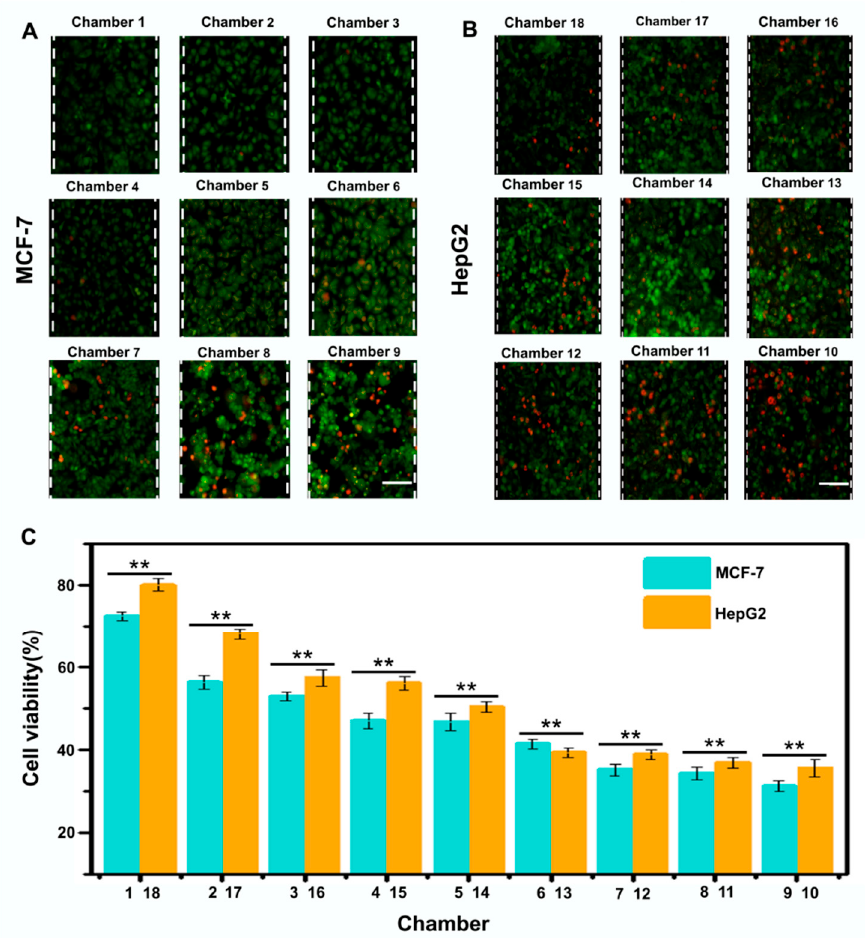
Figure 6. Responses of two tumor cells (human breast adenocarcinoma cells (MCF-7) and human cervical carcinoma cells (HepG2)) to different drug-concentration gradients (paclitaxel). ( A , B ) Acridine orange/propidium iodide (AO/PI)-stained fluorescence images of MCF-7 cells (A) and HepG2 cells ( B ) in different microchambers after continuous drug action of different concentrations for 24 h. ( C ) Comparison of cell viability of MCF-7 cells and HepG2 cells. Standard deviations deduced from ten parallel experiments are shown as the error bars, with the significance assessed by analysis of variance (ANOVA).*P < 0.05 and **P < 0.01. Scale bar, 400 μ m.